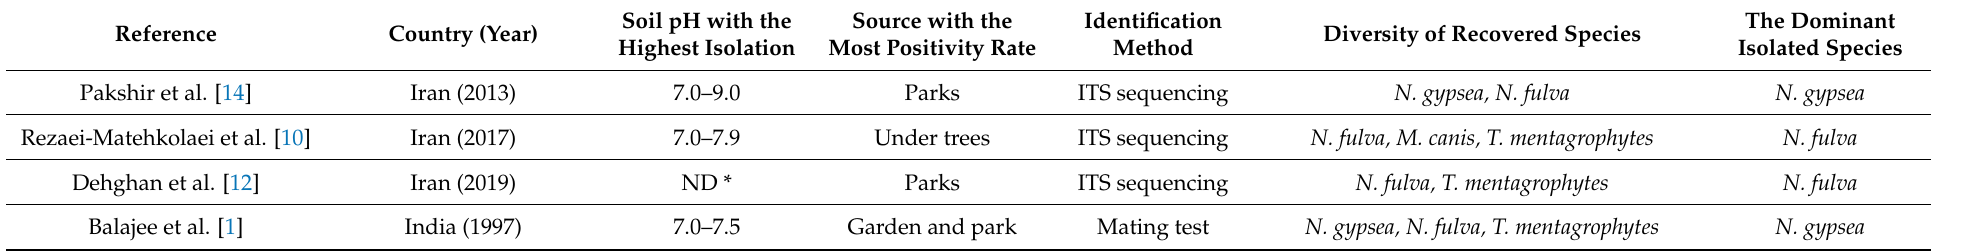
Table 3. A summary on the occurrence of dermatophytes in the soils from various